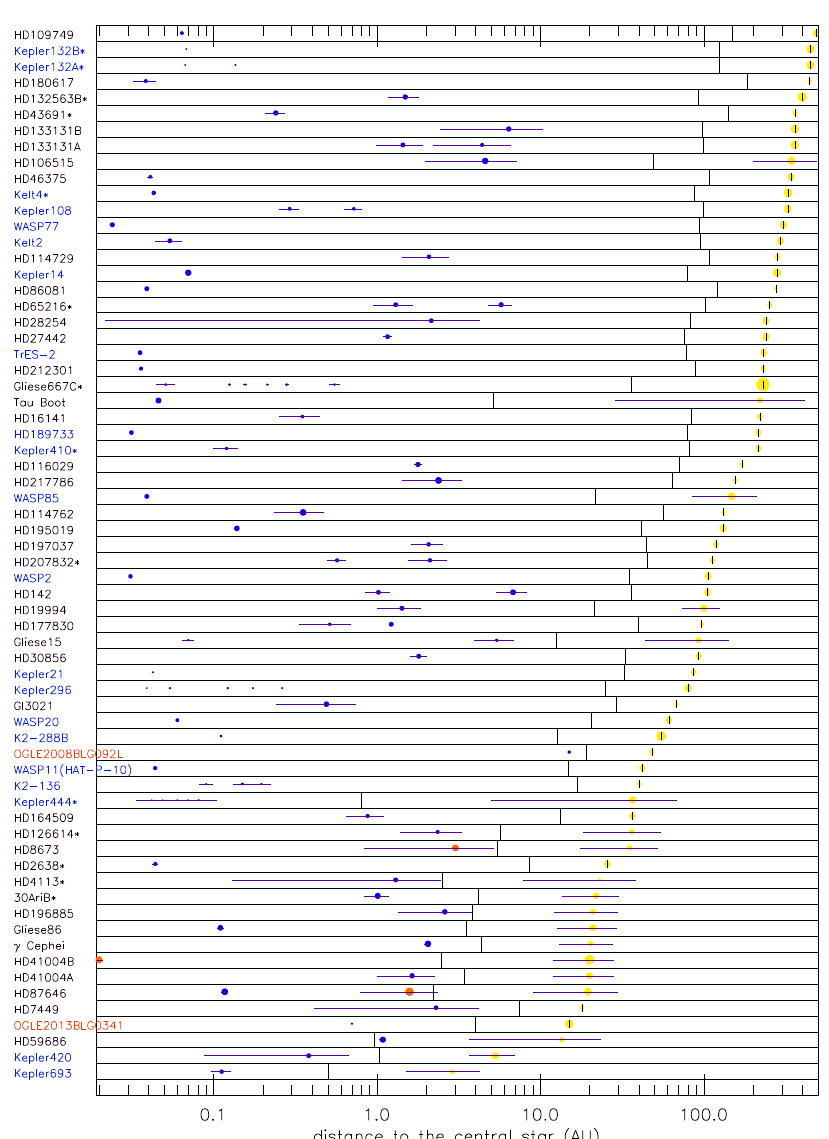
Figure 1. All circumstellar (S-type orbits, as opposed to circumbinary P-type orbits) planet-hosting binaries with separation ≤ 500au (as of July 2019). Companion stars are displayed as yellow circles, whose radius is proportional to ( M 2 / M 1 ) 1/3 . Planets are marked as blue circles whose radius is proportional to ( m pl ) 1/3 . The horizontal lines represent the radial excursion of the planet and star orbits (when they are known). When the binary orbit is known, the displayed distance is the semi-major axis, otherwise it is the projected current separation. The short vertical lines correspond to the outer limit of the orbital stability region around the primary estimated by Holman and Wiegert [7] assuming prograde orbits and coplanarity (for the seemingly “unstable” planet HD59686Ab, a retrograde orbit was suggested as a possible stable solution [8]. Planets detected by the radial velocity method are written in black, planets detected by transit are in blue, and planets detected by other methods are in